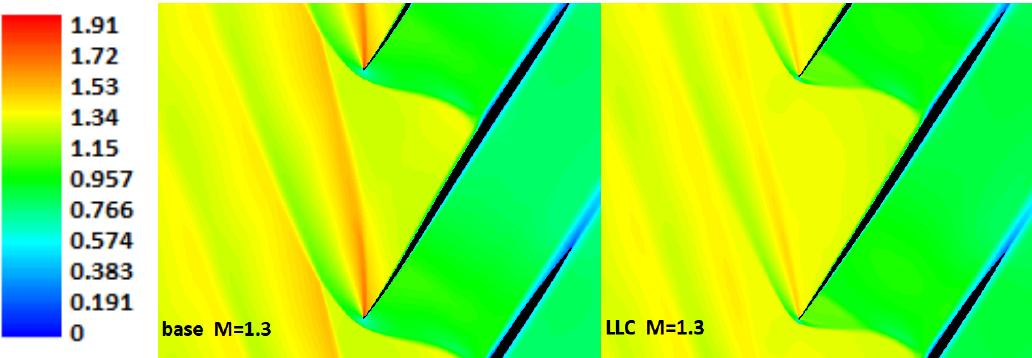
Figure 11. Mach contours of profiles with LLC at Mach